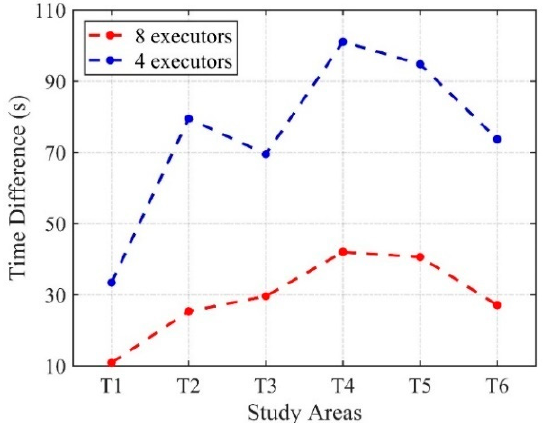
Figure 9. The time difference between S1 and S2 under various numbers of executors. Table 6. The mutable parameter settings of the Spark submit. Element Settings Group 1